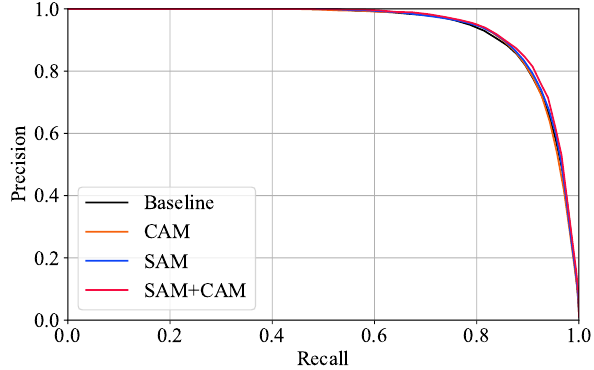
Figure 7. Relation between precision and recall for the four methods